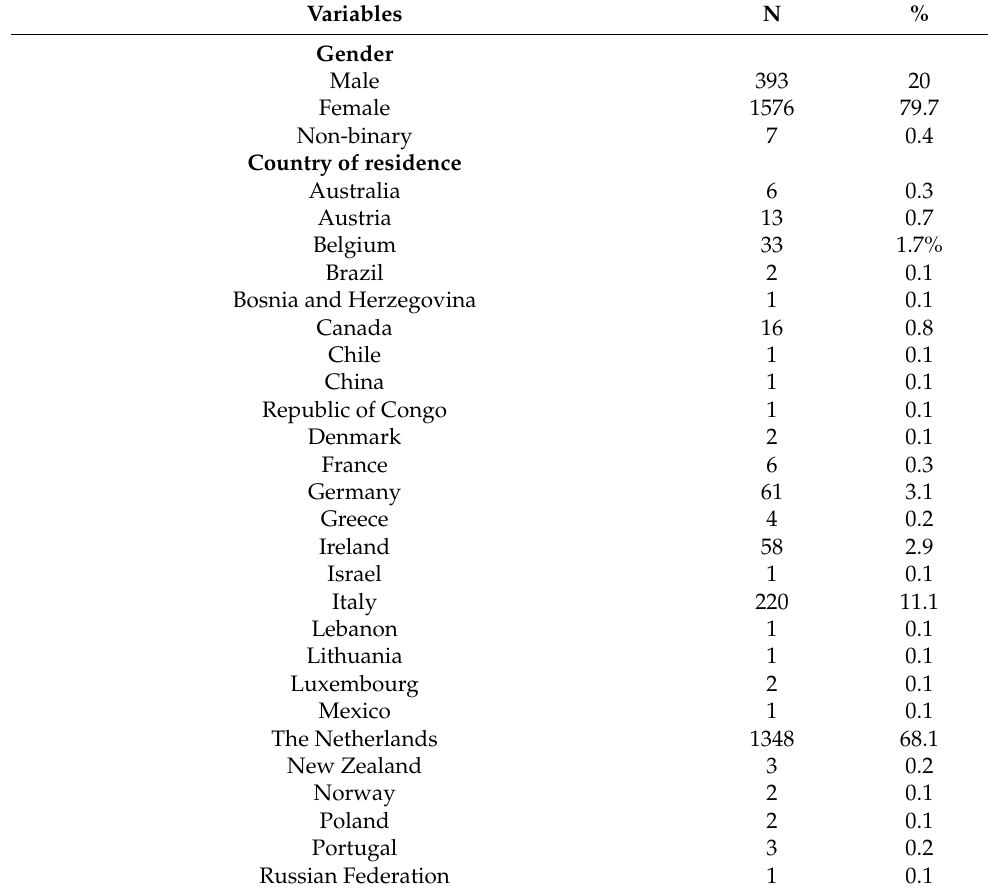
Table A1. Demographics of sample